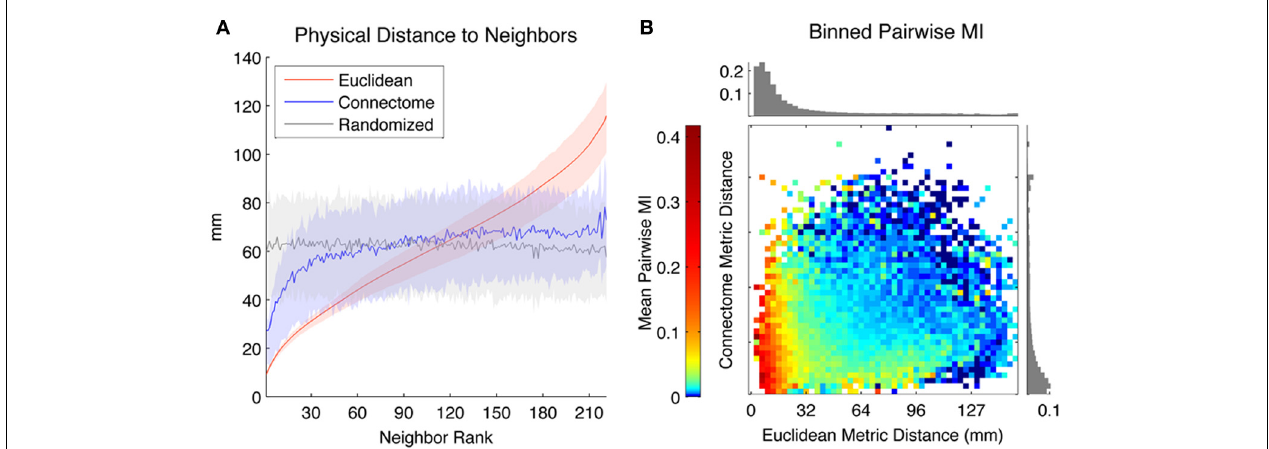
FIGURE 2 | (A) Mean physical distance between seeds and their k th neighbors, where neighbors are ranked according to three metrics: Euclidean (red), Connectome (blue), and Randomized (gray) (averaged across all ROIs, with solid line representing mean physical distance and shaded areas indicating first and third quartiles). (B) Mean Pairwise MI between pairs of ROIs separated by different Euclidean (horizontal axis) and Connectome